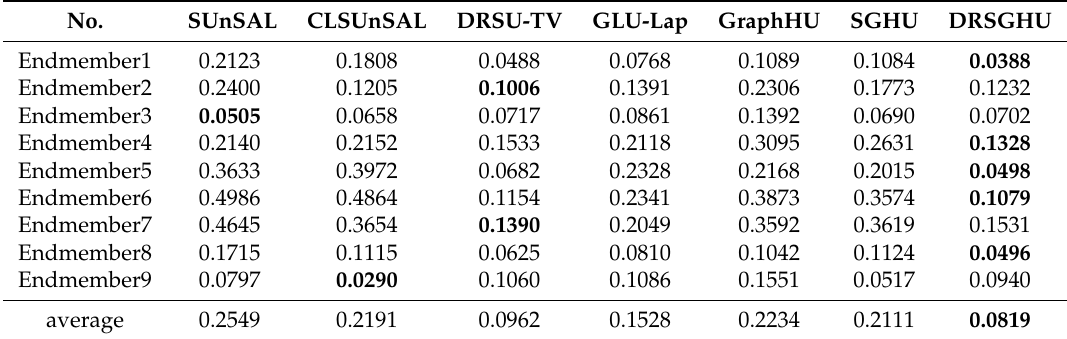
Figure 2. The data is contaminated with Gaussian white noise with SNR of 30 dB. Abundances estimated by DRSGHU of DC1 ( α 1 = 0.01, α 2 = 1, β = 0.5). Table 2. Relative errors of the estimated fractional abundances of chosen endmembers for a noise level of 30 dB of